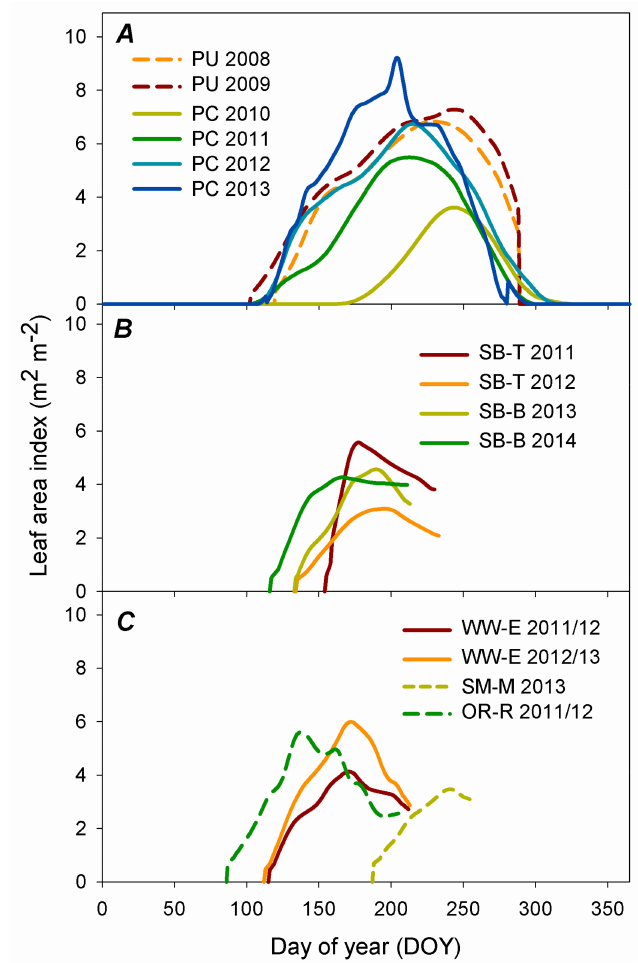
Figure 2. The time course of leaf area index (LAI) in SRC poplar clone J-105 ( A ) uncoppiced (PU)